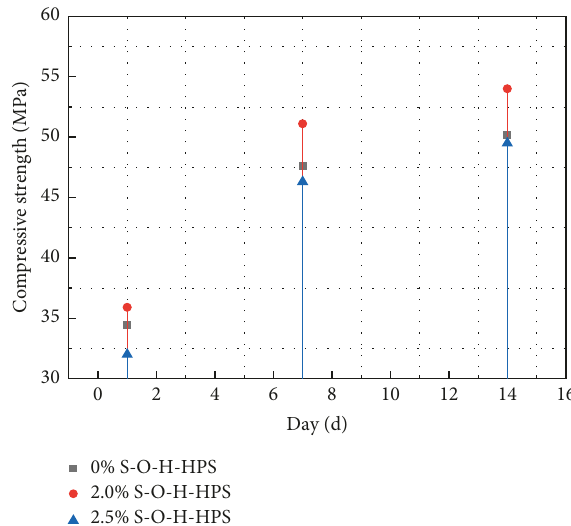
Figure 10: Effect of curing age on compressive strength of cement